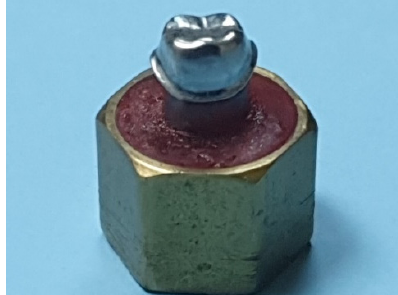
Figure 1. Master metal